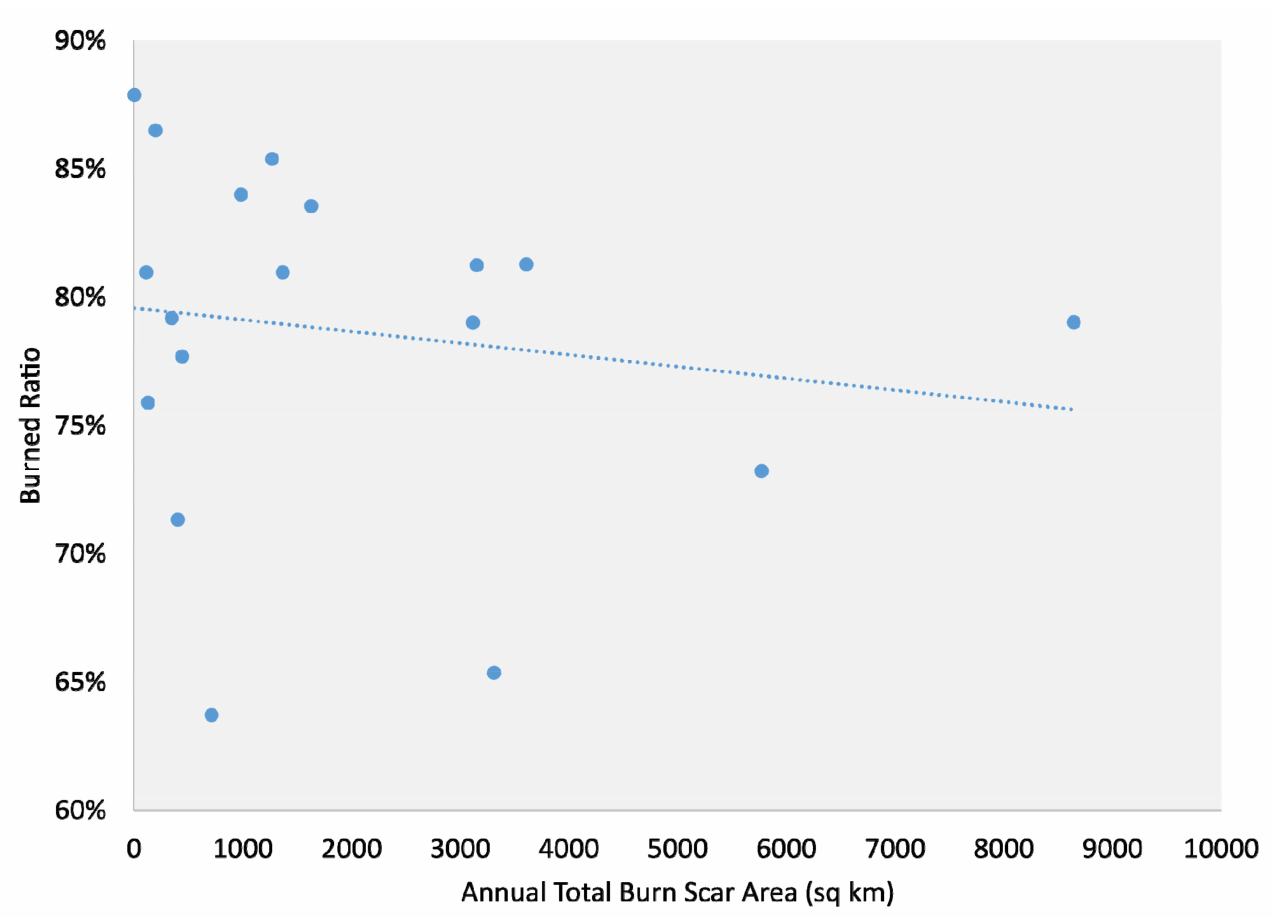
Figure 6. Scatterplot showing the relationship between annual total burn scar area (in km 2 ) during 1984–2002 and the corresponding Burned Ratio, as identified based on the MTBS